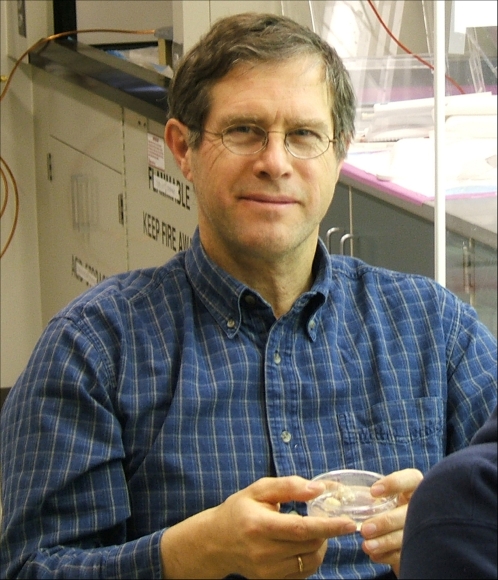
Evgenii Ananiev.